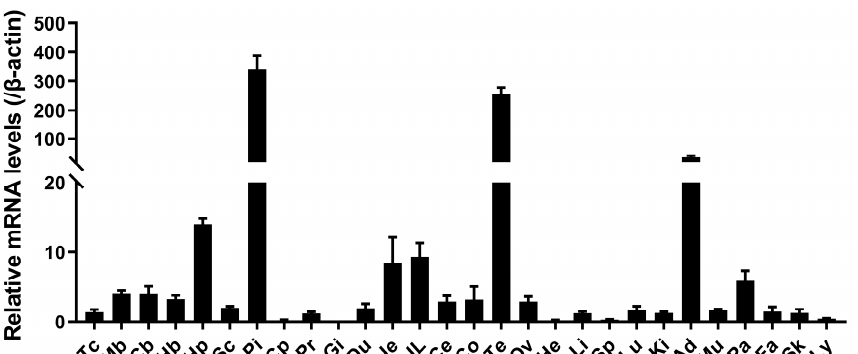
Figure 4. The expression profiles of SPX2 in adult chickens. Quantitative real-time PCR assay of cSPX2 in chicken various tissues, including the telencephalon (Tc), midbrain (Mb), cerebellum (Cb), hindbrain (Hb), hypothalamus (Hp), spinal cord (Sc), anterior pituitary (Pi), crop (Cp), proventriculus (Pr), gizzard (Gi), duodenum (Du), jejunum (Je), ileum (IL), caecum (Ce), colon (Co), testes (Te), ovary (Ov), heart (He), liver (Li), spleen (Sp), lung (Lu), kidney (Ki), adrenal gland (Ad), muscle (Mu), pancreas (Pa), abdominal fat (Fa), skin (Sk), and lymph (Ly). The mRNA levels of cSPX2 were normalized to that of β -actin and expressed as the fold difference compared with that of telencephalon (Tc). Each data point represents the mean ± SEM of 6 adult chickens ( n = 6).